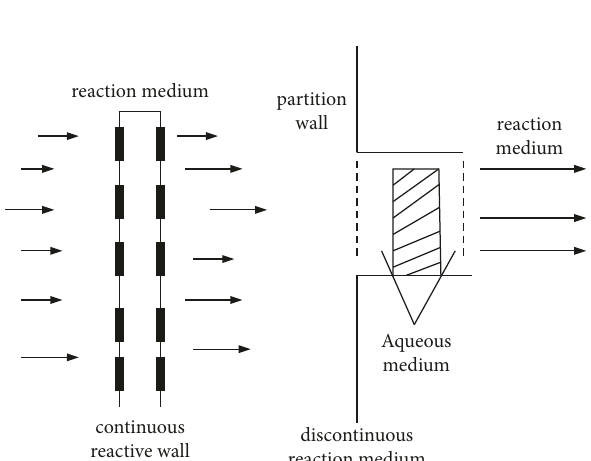
Figure 3: GCW technology.